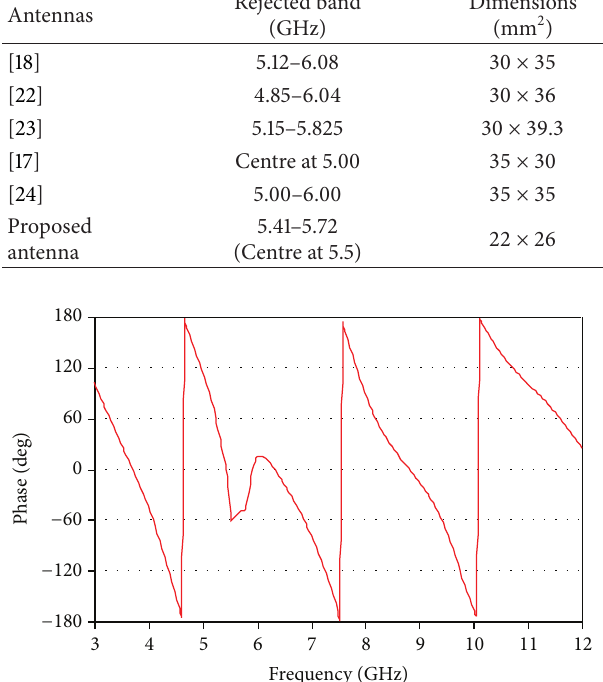
Figure 9: Measured phase variation of the input impedance.